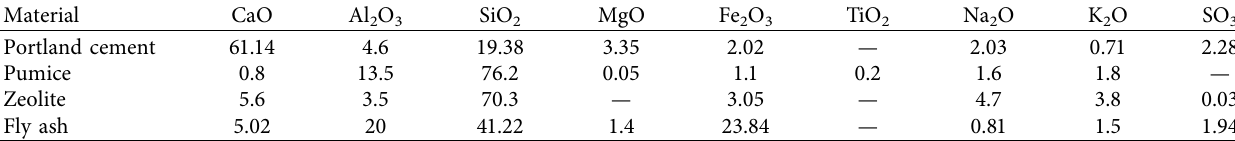
Table 2: Chemical composition of Portland cement and supplementary cementitious materials (wt.%).